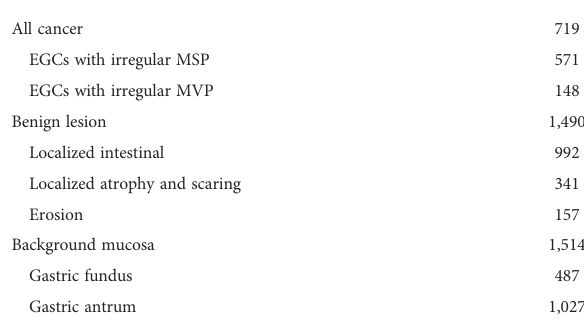
TABLE 1 Image composition of training